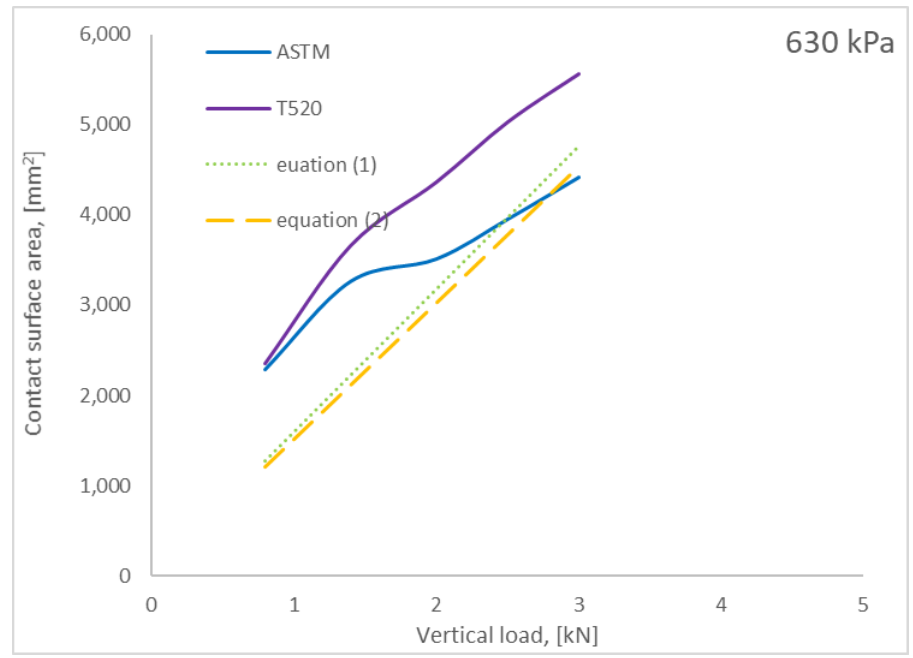
Figure 20. Contact surface area of the ASFT tires with surface, in relation to the load for wheel pressure of 630 kPa.